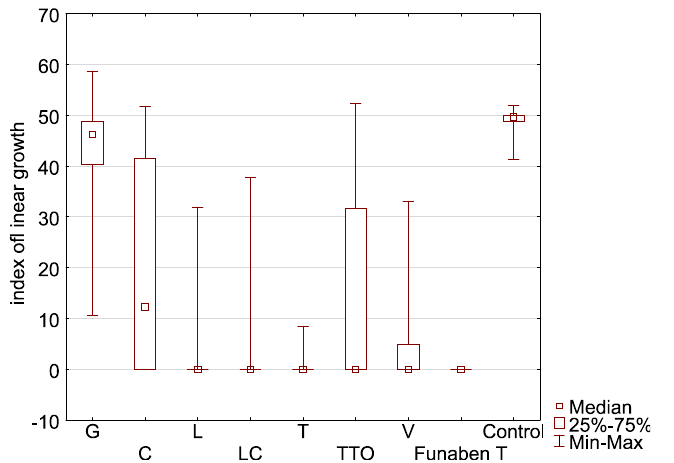
Figure 6. Characteristic of the indexes of linear growth (T) of Fusarium spp. isolates (aggregate num-